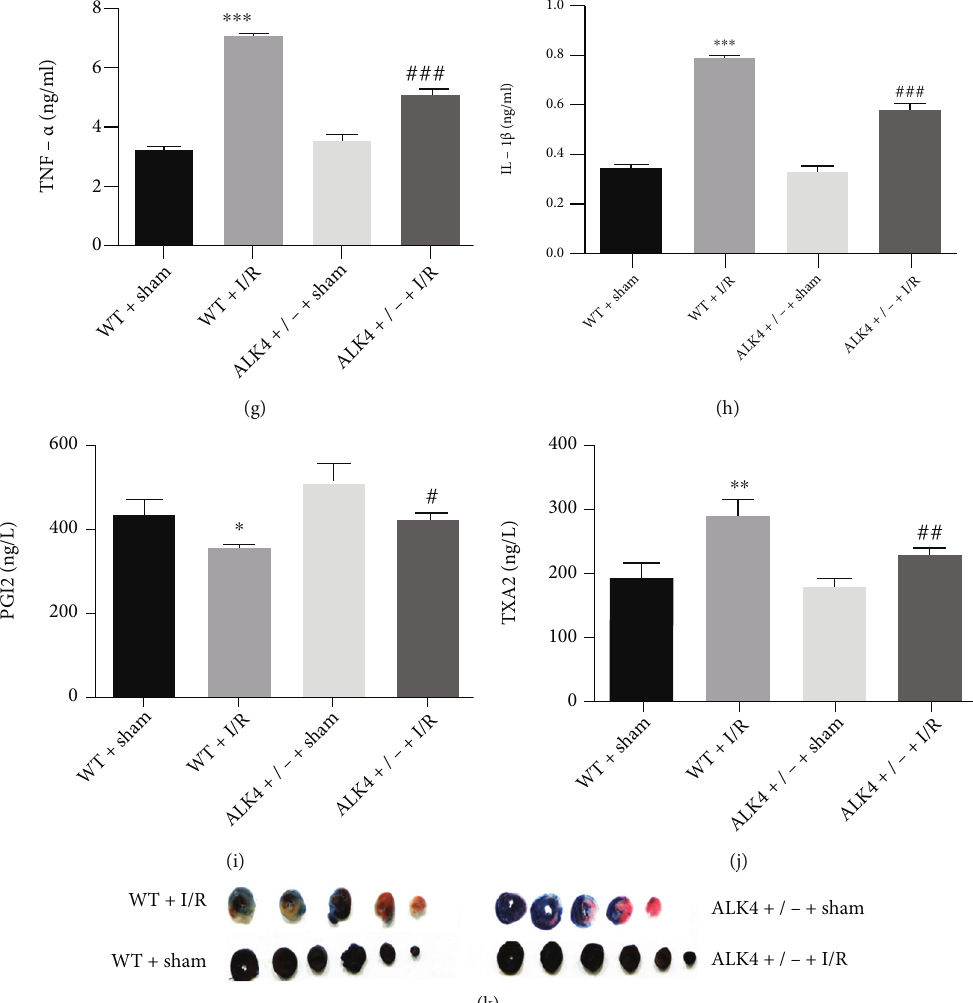
Figure 1: Serum levels of related factors in di ff erent groups: WT, ALK4-NC, ALK4-NC+I/R, and ALK4-KO+I/R groups. (a) The hydroxylamine method was used to detect SOD level at 24 h after I/R. (b) The thiobarbituric acid method was employed to detect MDA level at 24 h after I/R. (c – e) Serum levels of CK, LDH, and AST were assessed with corresponding ELISA kits at 24h after I/R. (f – h) In fl ammation related factors (IL-6, TNF- α , and IL-1 β ) were detected with corresponding ELISA kits at 24 h after I/R. (i and j) The serum levels of PG12 and TXA2 were detected with corresponding ELISA kits at 24h after I/R. (k) Representative images of nonischemic zones (blue) and infracted tissue (white) within the AAR (absence of blue dye). Data are expressed as mean ± SD . ∗ P < 0 : 05 , ∗∗ P < 0 : 01 , and ∗∗∗ P < 0 : 001 , WT+I/R group vs. WT+sham group. # P < 0 : 05 , ## P < 0 : 01 , and ### P < 0 : 001 , ALK4 +/- +I/R group vs. WT+I/ R